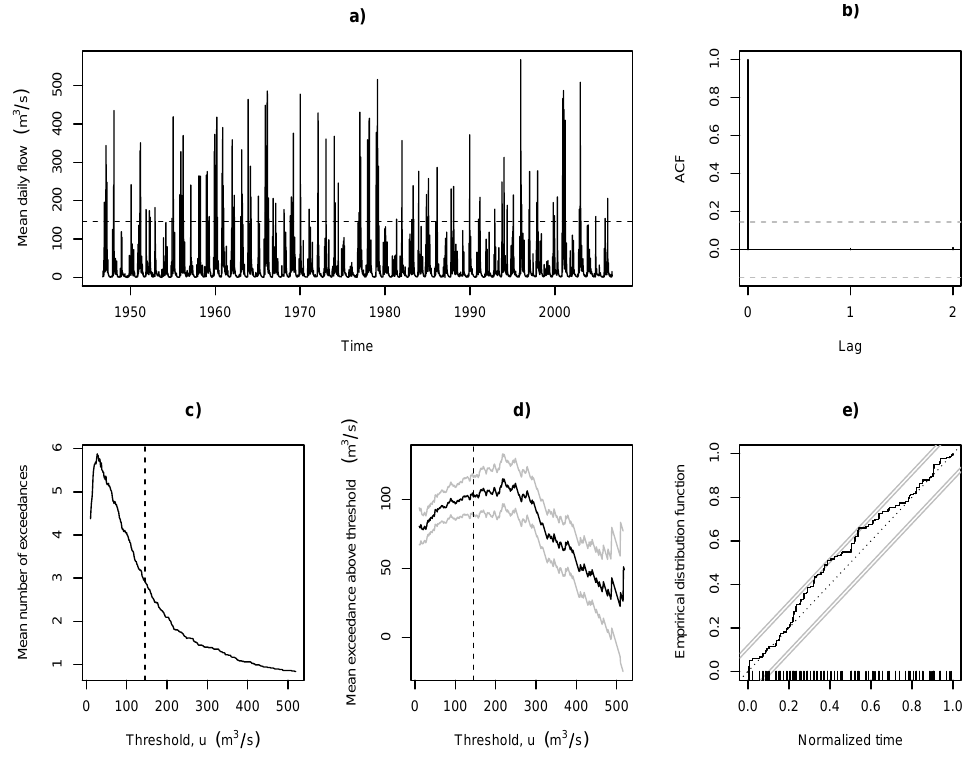
Fig. 2. Peaks-over-threshold sampling technique applied to sample S5 – Fragas da Torre. (a) Mean daily flow sample; (b) autocorrelation function (ACF) of the exceedances with a 95% confidence band; (c) mean number of exceedances in a year, (d) mean exceedance over the threshold with a 95% confidence band; and (e) empirical distribution function of the times of the events. The selected threshold is identified by the dashed lines in panels (a) , (c) and (d) . In panel (e) , the vertical ticks show the points in time associated with the flood occurrences, the dotted diagonal line shows the uniform distribution and the solid diagonal lines show significance for a Kolmogorov-Smirnov statistic at 5% and 1%.